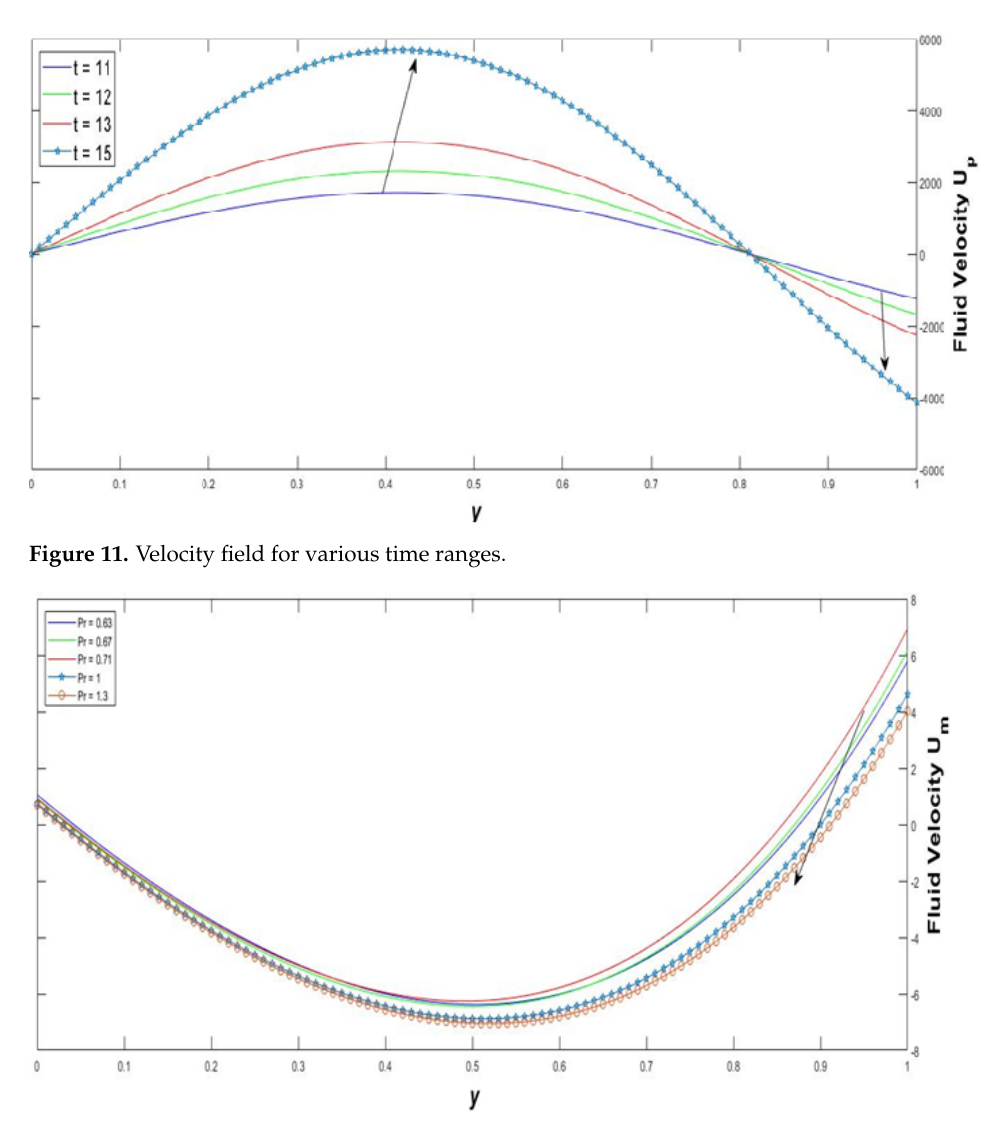
Figure 12. Velocity field for various Prandtl numbers.